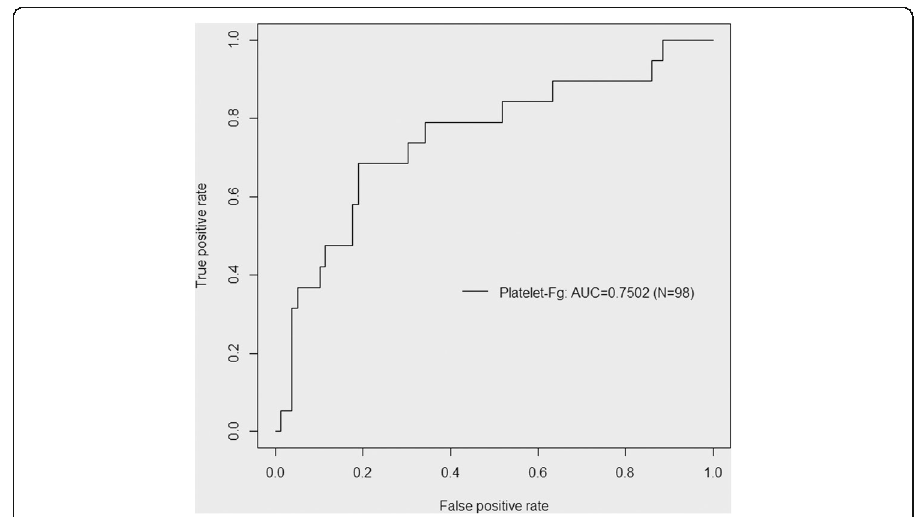
Fig. 2 Predictive value of platelet-Fg (%) obtained at admission. ROC curve analysis of sepsis prediction based on platelet-Fg is